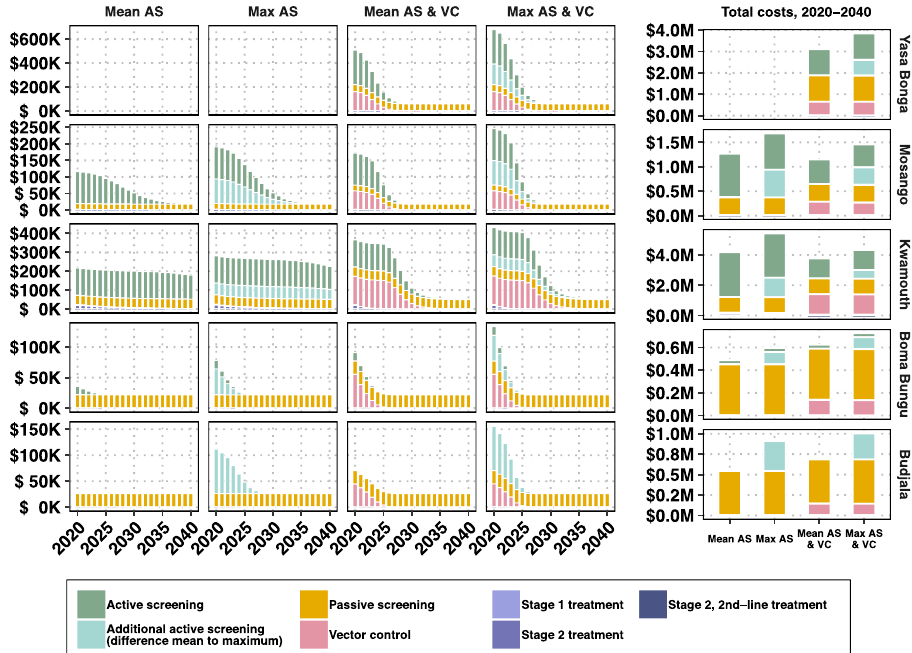
Fig. 3 Components of annual and cumulative costs, by strategy and location. Expected costs are the product of the average cost of each component of prevention, detection, and treatment and the probability that activity have not ceased. Displayed costs are not discounted. Treatment costs, indicated in purple, are shown here although they are so small as to be hardly visible.